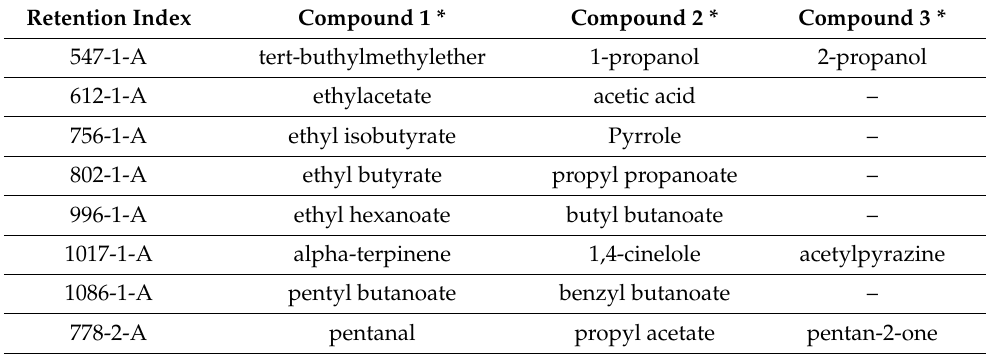
Figure 6. Spider plot of intensities (mean ± SD) of the sensors specifically selected to provide the best classification of the samples according to the different S17-P100 concentrations (SMPL-CTR: milkshake with no supplementation (control); SMPL#1 to SMPL#10: milkshakes with increasing levels of DHA supplementation (0.2–2%)). Table 6. Assignment of possible volatile compounds to the retention indices of the selected qualitative sensors using the AroChemBase database (Alpha MOS, Toulouse, France). Retention Index Compound 1 * Compound 2 * Compound 3 * 547-1-A